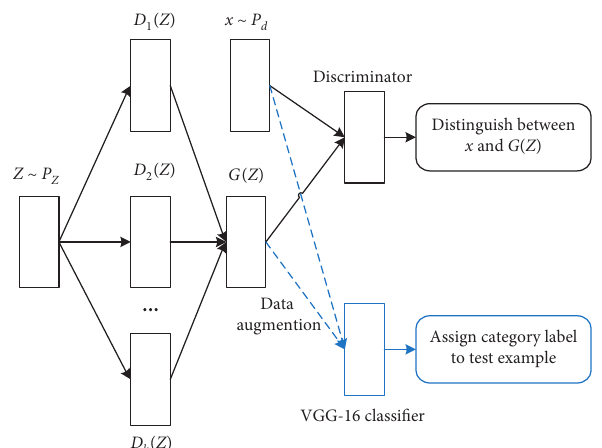
Figure 7: Structure of MD-GAN for data augmentation and VGG- 16 network for classification, where Z ∼ P z means the normal distribution, D k ( Z ) refers to multiple distribution generators, and G ( Z ) and x ∼ P d represent generated training samples and original training samples,